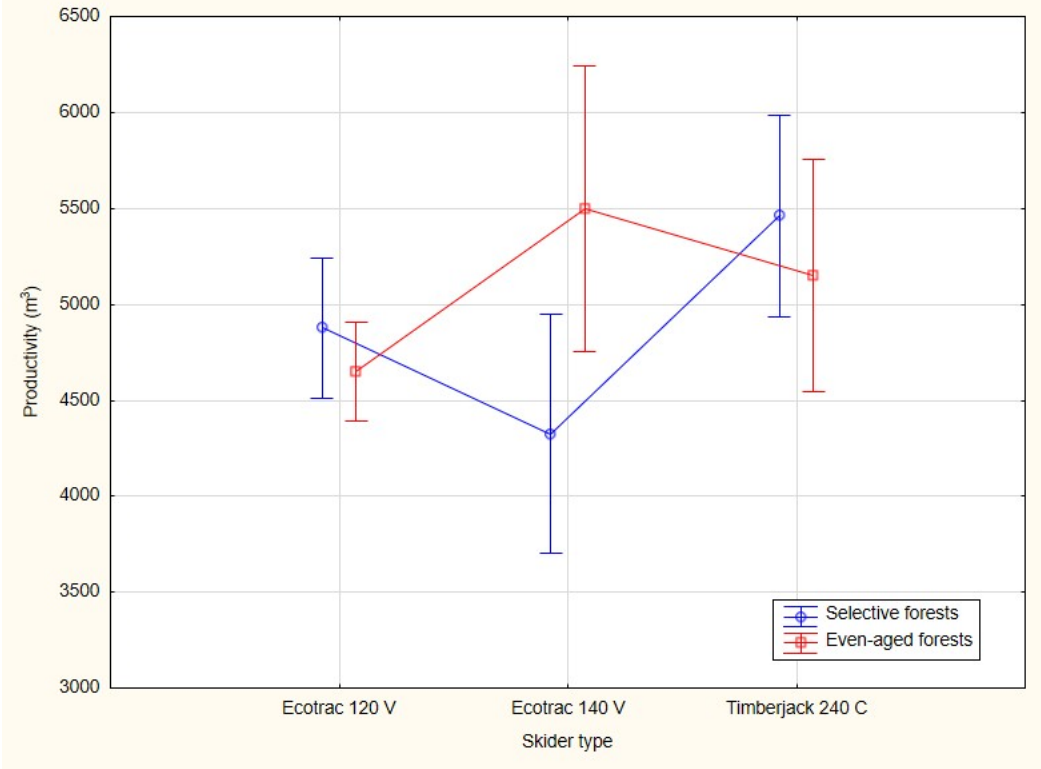
Figure 4. Total average productivity of skidders.